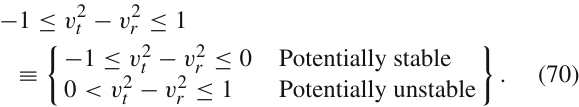
Fig. 7 The variation of radial (v 2 r ) and transverse (v 2 t ) velocity of sound and stability factor ( | v 2 r − v 2 t | ) (left panel) and different forces in TOV equation for a static configuration (right panel) with the radial coordinate r for experimental statistics of four different compact stars.